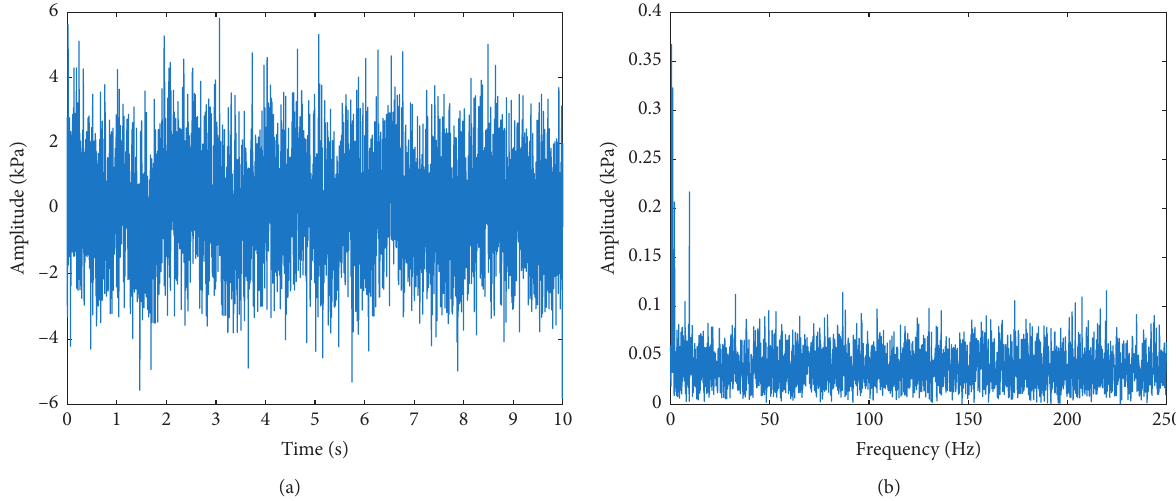
Figure 3: Simulation of noise addition waveform and spectrum diagram. (a) Waveform diagram. (b)